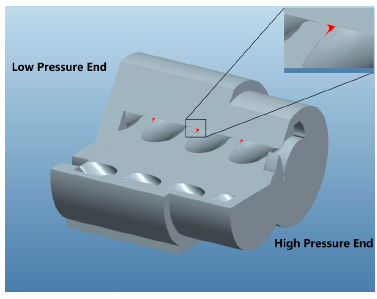
Figure 6. Blowhole. Figure 6. Blowhole.